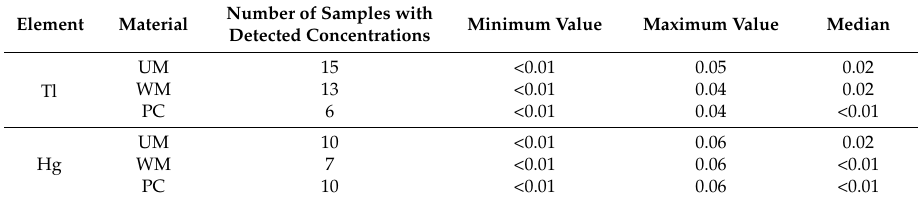
Table 2. Concentrations of Tl and Hg (mg · kg − 1 DM) in leaf litter of urban street trees. UM, unwashed material; WM, washed material; PC, press cake. Minimum, maximum and median values refer to the full data set of 24 samples.